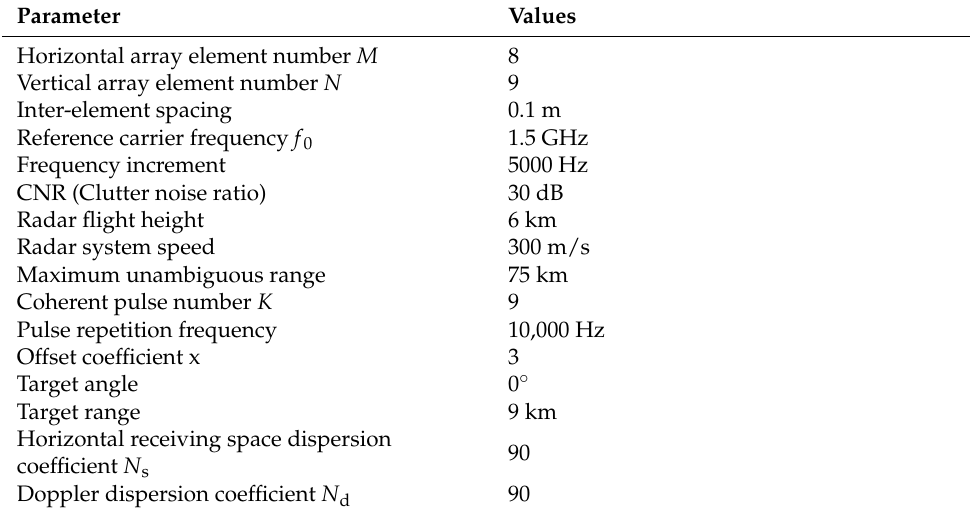
Table 1. Simulation Parameters